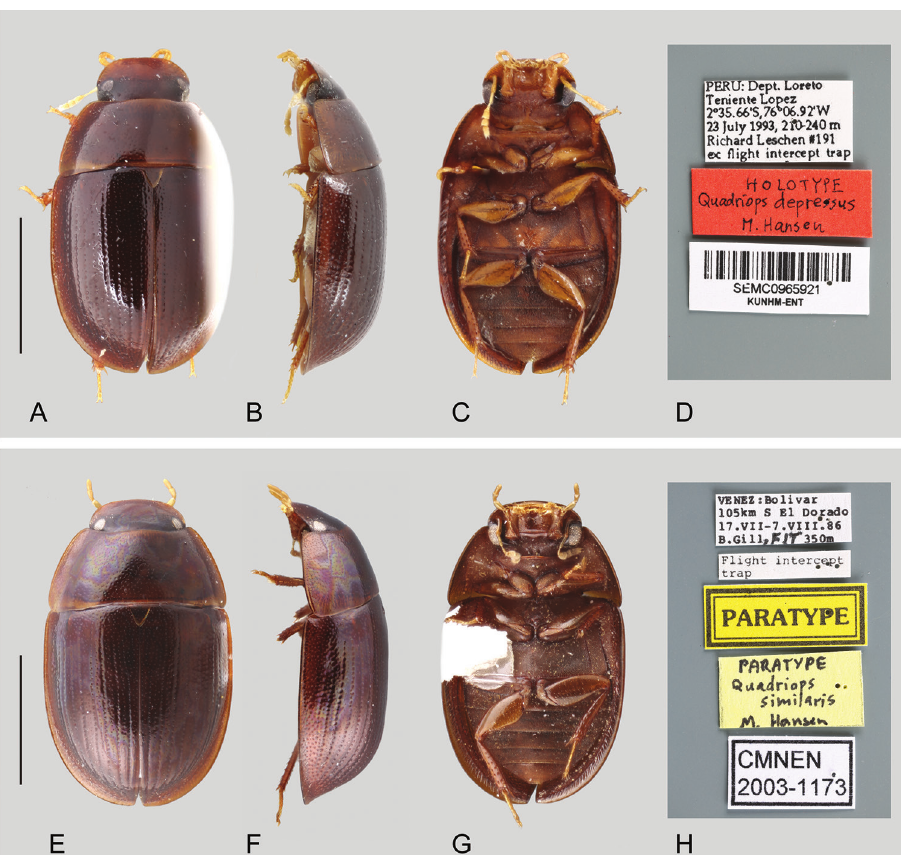
Figure 2. Habitus and labels of Quadriops spp.: Q. depressus (holotype): A dorsal view B lateral view C ventral view D labels; Q. similaris (paratype): E dorsal view F lateral view G ventral view H labels. Scale bar 1